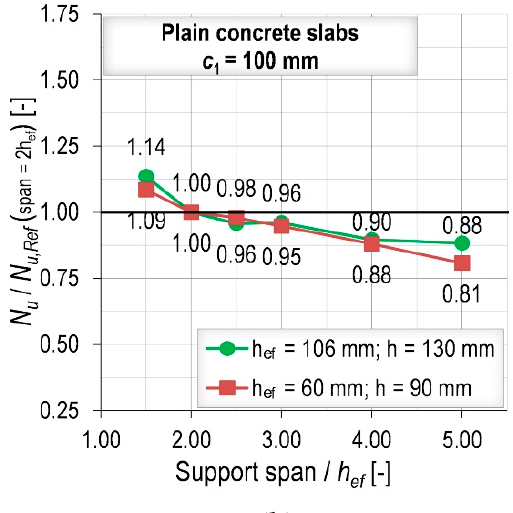
Figure 4. Comparison between experimental and numerical LD curves obtained for: ( a ) member thickness h = 70 mm; ( b ) member thickness h = 130 mm.